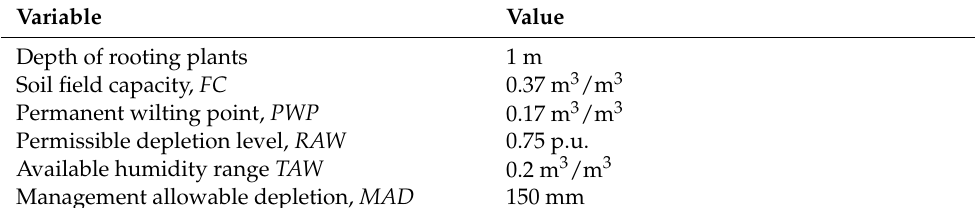
Table 6. Characteristics of the soil of the farm under study.